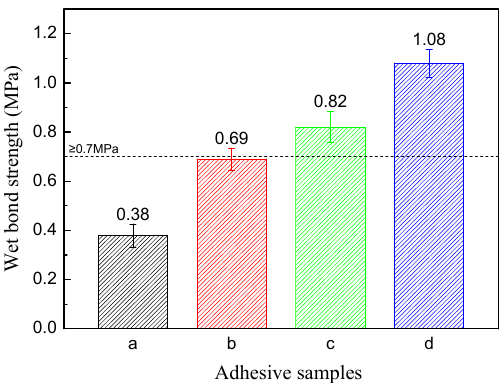
Figure 4. The wet bond strength of the plywood with different adhesives: ( a ) SF adhesive; ( b ) SF/LB adhesive; ( c ) SF/PAE adhesive; and ( d ) SF/LB/PAE adhesive.